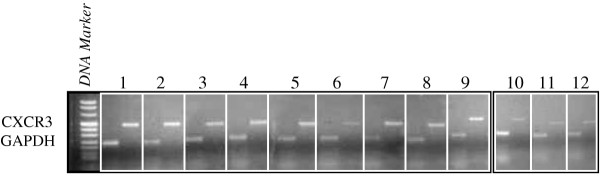
Semiquantitative RT-PCR determination of CXCR3 expression in patients and controls. Unnumbered frame: DNA marker. Representative results of agarose-gel electrophoresis of RT-PCR products of CXCR3 mRNA (456 bp) and glyceraldehyde-3-phosphate dehydrogenase (234 bp) for nine patients (frames 1–9) and three controls (frames 10–12).